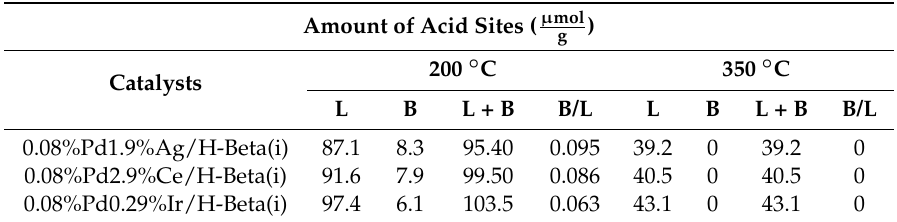
Table 3. Amounts of Lewis (L) and Brønsted (B) acid sites determined by Fourier–transform infrared spectroscopy (FTIR) of pyridine adsorption for various catalysts.